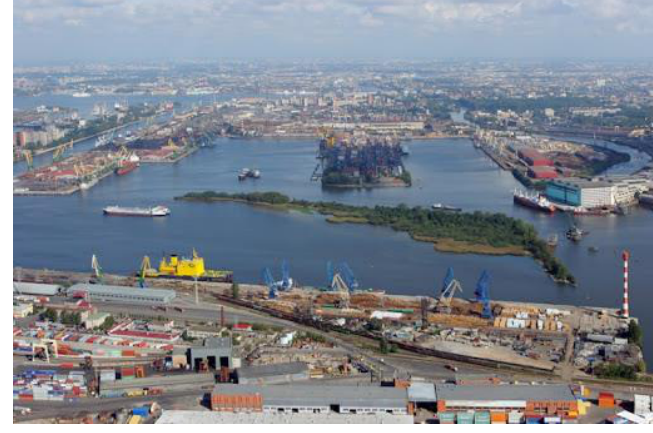
14 of 30 Figure 9. Primorsk Commercial Sea Port. Source: [78]. The main characteristics of the port are as follows: •